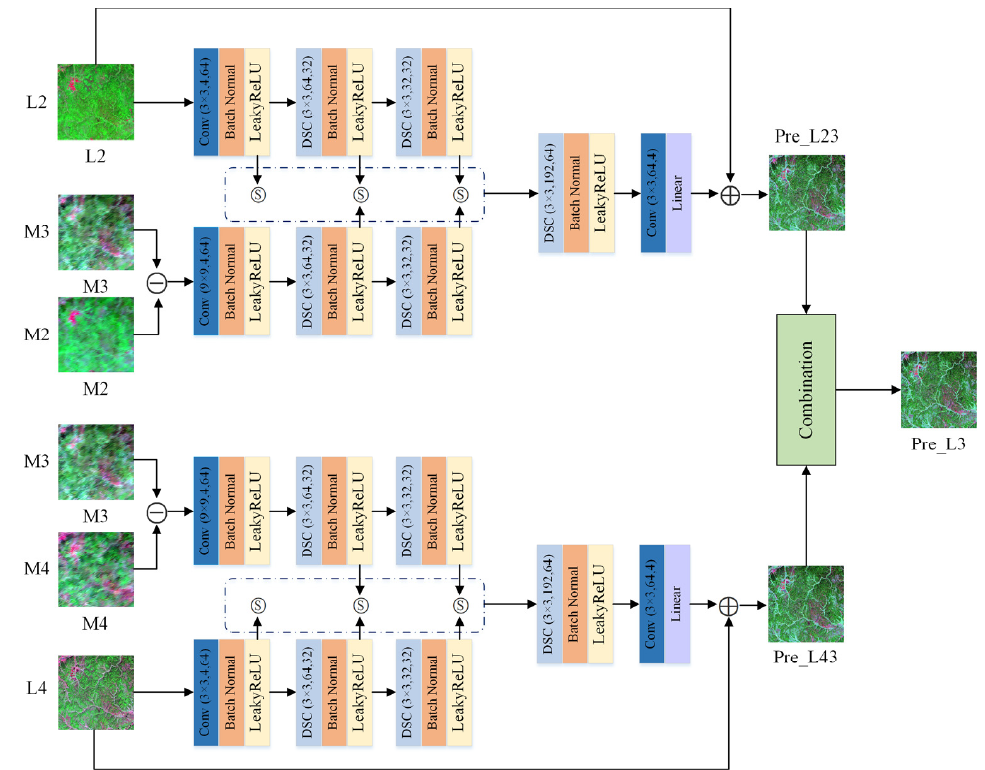
Figure 2. Architecture of the STFDSC model. Inputs of the STFDSC model were Landsat and MODIS data at base times (L2, L4, M2, and M4), and MODIS data at the prediction time (M3). Pre_L23 and Pre_L43 were predicted Landsat data using two sub-models, and Pre_L3 was the final Landsat prediction and obtained by weighted average of Pre_L23 and Pre_L43. 224 The final predicted result ( Pre_L 3 ) was a weighted combination of two-stream pre- 225 dictions [47]. For each band, the weight was calculated according to the difference be- 226 tween each of the submodel predictions and the corresponding surface reflectance. A 227 smaller difference corresponded to a higher weight.